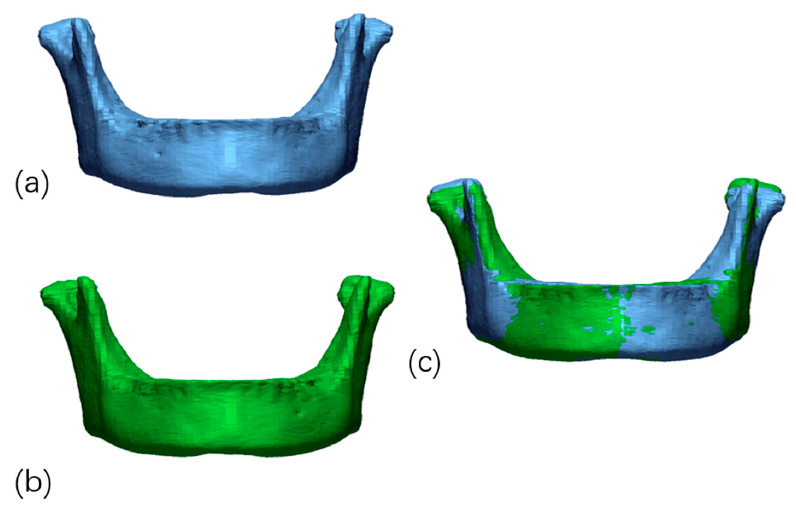
Figure 3. ( a ) The original mandible model; ( b ) the mirrored mandible model; ( c ) the original mandible model and the mirrored mandible model were given best-fit alignment by computer